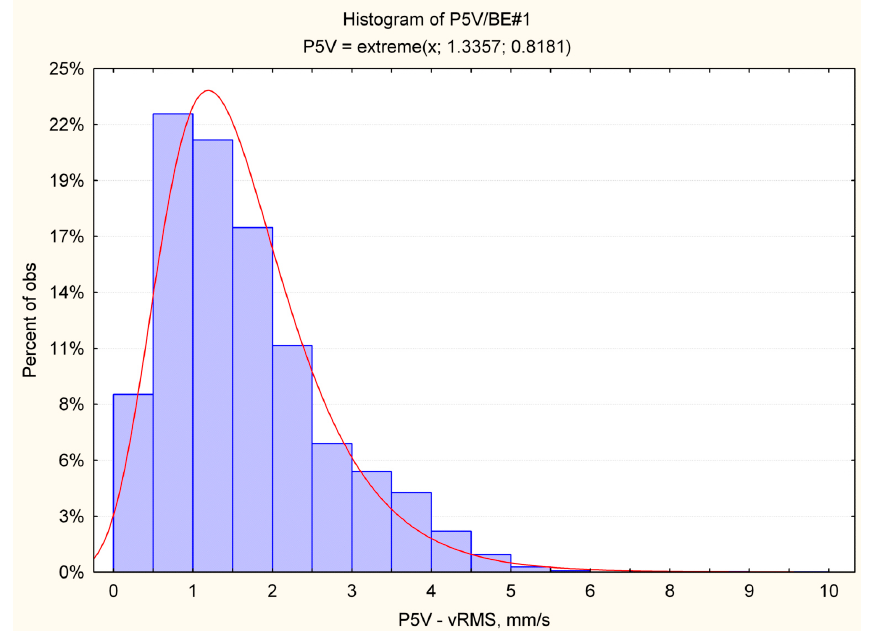
Figure 15. Histogram of vibration velocity v RMS and the estimated Gumbel Extreme Value model for point P5 (in the vertical direction) in bucket elevator BE#1.